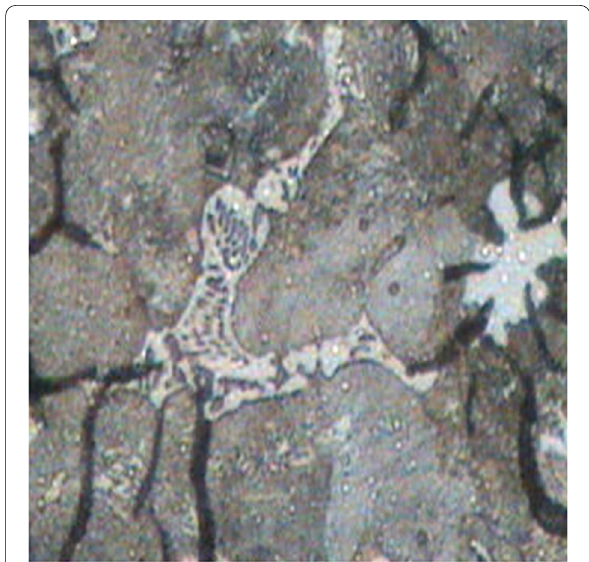
Fig. 7 Higher magnification represents graphite flakes, cementite, pearlite, and ledeburite. Etched in 5% Nital,